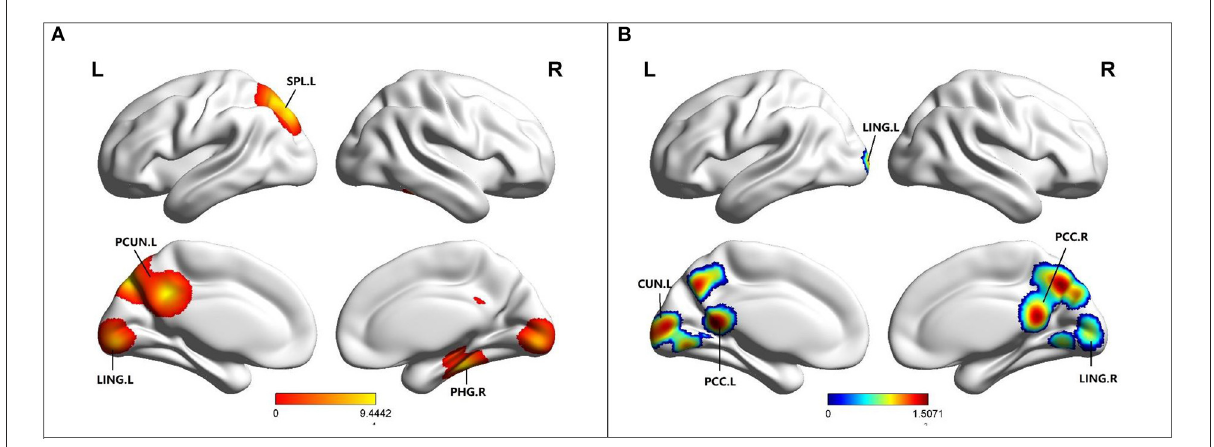
FIGURE4 (A) Brain regions showing increased ReHo in MCI patients compared to HCs. (B) Brain regions showing decreased ReHo in MCI patients compared to HCs. MCI, amnestic mild cognitive impairment; HCs, healthy controls; ReHo, regional homogeneity; PCUN, precuneus; PCC, posterior cingulate; PHG, parahippocampal gyrus; LING, lingual gyrus; SPL, superior parietal lobule; R, right; L, left.